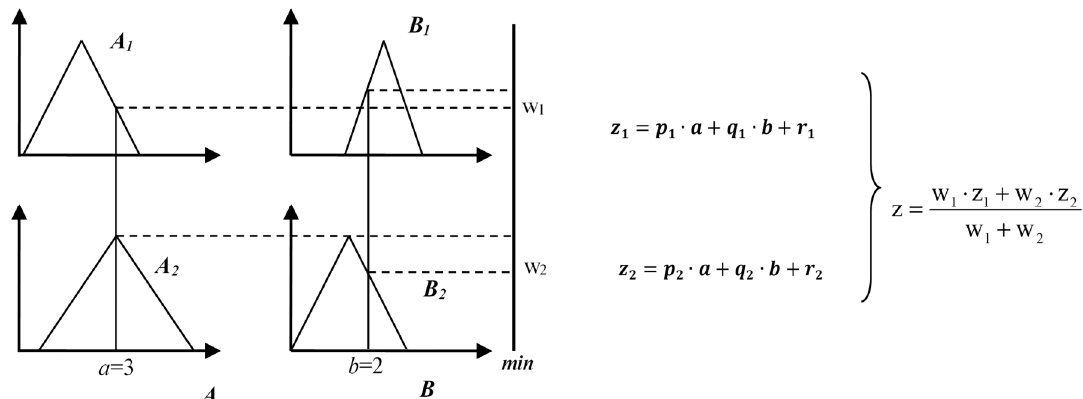
Figure 5. Example of how a Sugeno model works (evaluation of two fuzzy rules with two input variables or antecedents, a = 3 and b = 2) [28].